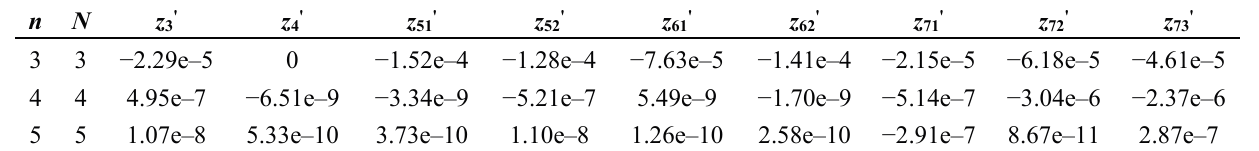
Table a2. The z ' s for Song [9]